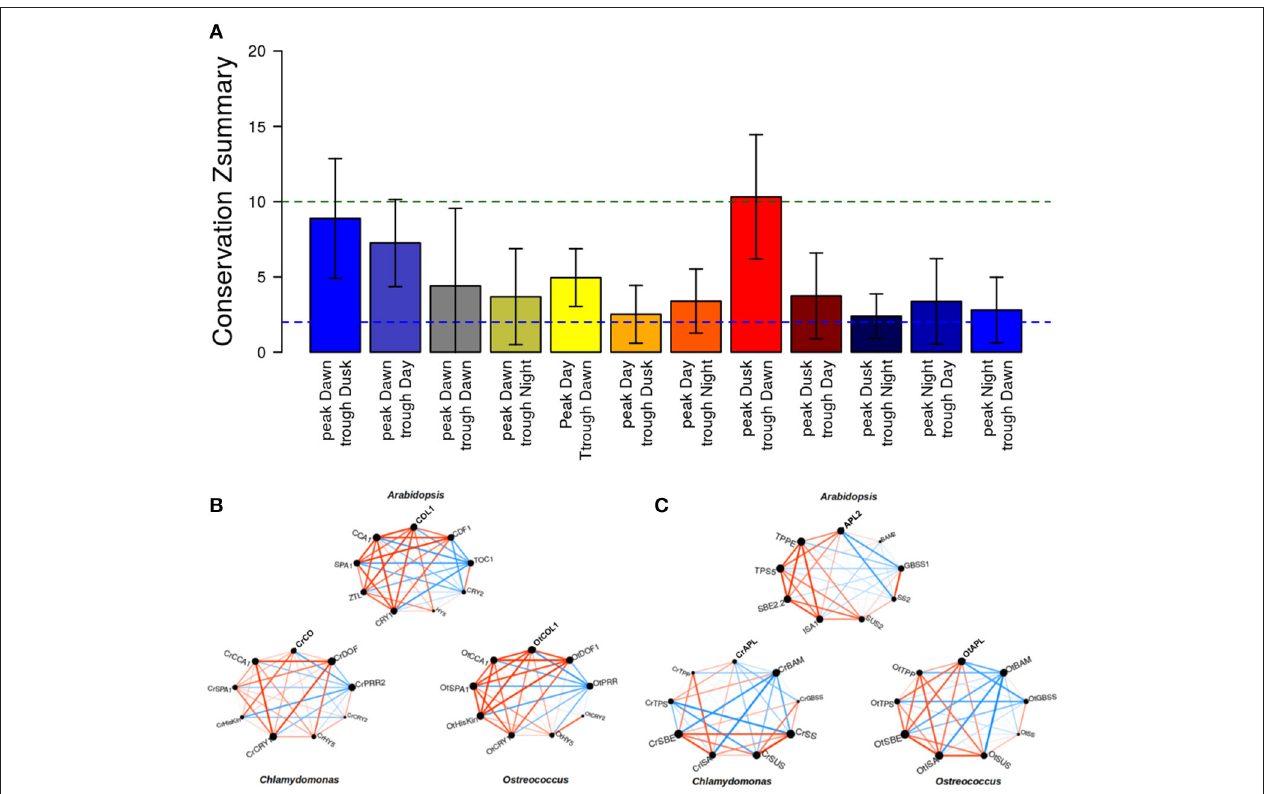
FIGURE 10 | Conservation of circadian patterns in Arabidopsis , Chlamydomonas, and Ostreococcus . (A) The average and standard deviation of the Zsummary conservation score between the three different species was computed for all clusters capturing different daily rhythmic patterns. Only clusters that exhibit a periodic pattern with peak or trough at Dusk or Dawn are significantly conserved over the three different species. (B) The co-expression pattern of the key circadian/photoperiod regulators exhibits a high level of conservation in the three species, but it is more evident for Arabidopsis and Ostreococcus . Red edges represent positive correlation between the corresponding gene expression profiles whereas blue edges indicate negative correlation. Edge width is proportional to the absolute value of the correlation between the corresponding expression profiles. (C) The co-expression patterns between key enzymes in starch/sucrose metabolism are highly conserved among the three different species with slight differences in Chlamydomonas